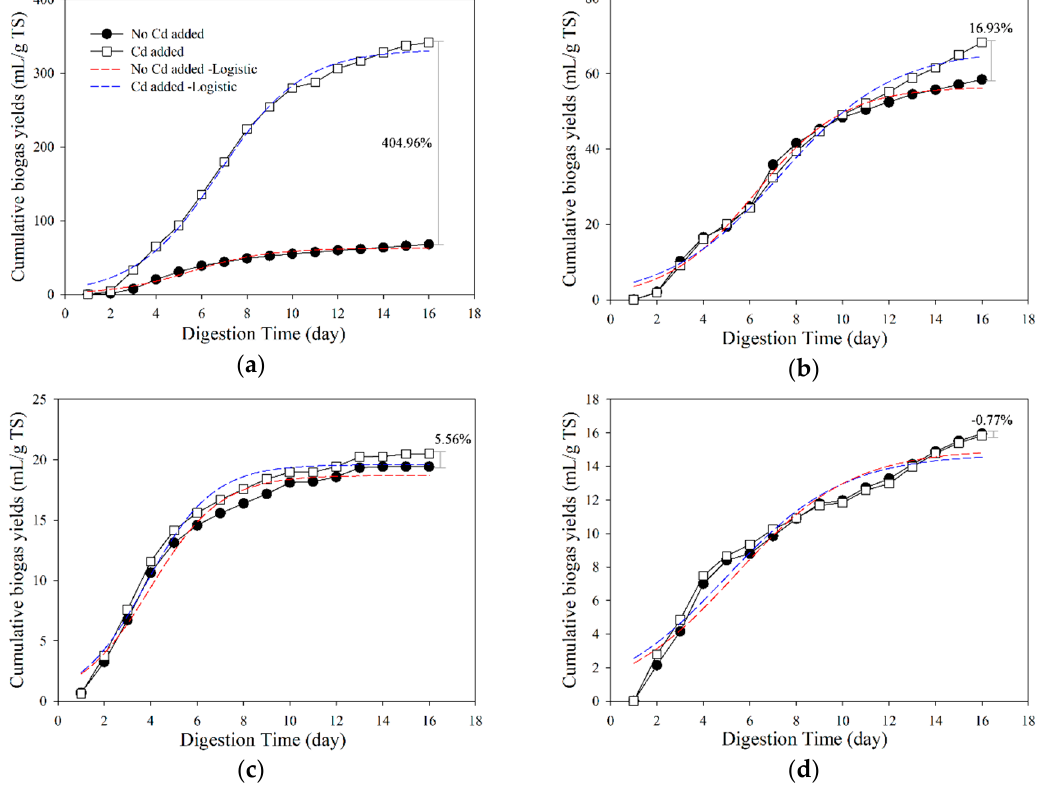
Figure 2. Cumulative biogas yields and logistic fitting results under Cd stress with digestion temperatures of 55 °C ( a ), 45 °C ( b ), 35 °C ( c ), and 25 °C ( d ).